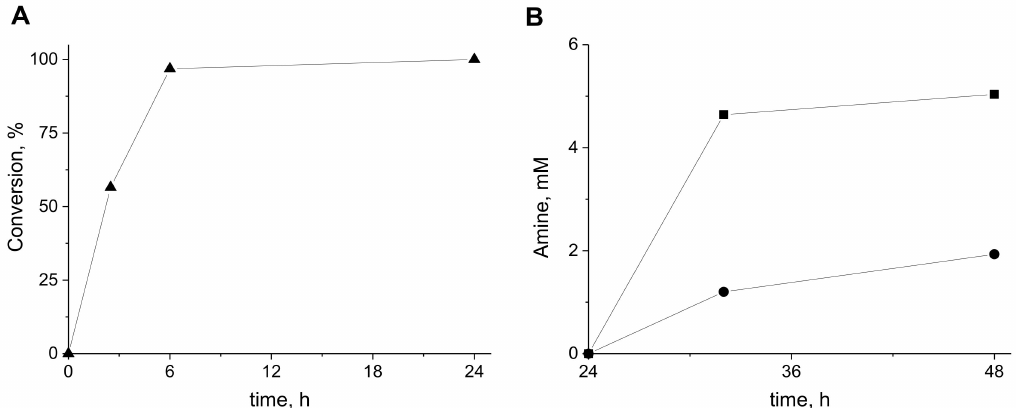
Figure 3. Results of the direct amination of 1-phenylethanol ( 5a ) in a one-pot two-step fashion. ( A ) Conversion of 5a ( (cid:78) ); ( B ) Production of 5c with BM ω TA ( (cid:4) ) and AT ω TA ( • ) enzymes; Reaction conditions: ( A ) 1 mL MilliQ water containing [ 5a ] = 10 mM, [SAS] = 0.75 mM. Samples were incubated at 30 ◦ C and irradiated under visible light ( λ > 400 nm); ( B ) 0.5 mL pH 9 reaction mixture containing [NaPI] = 50 mM, [IPA] = 1 M, [PLP] = 1 mM, [crude cell extract overexpressed with ω -TA enzyme] = 10 mg/mL. Samples were incubated on a shaking plate at 30 ◦ C at 600